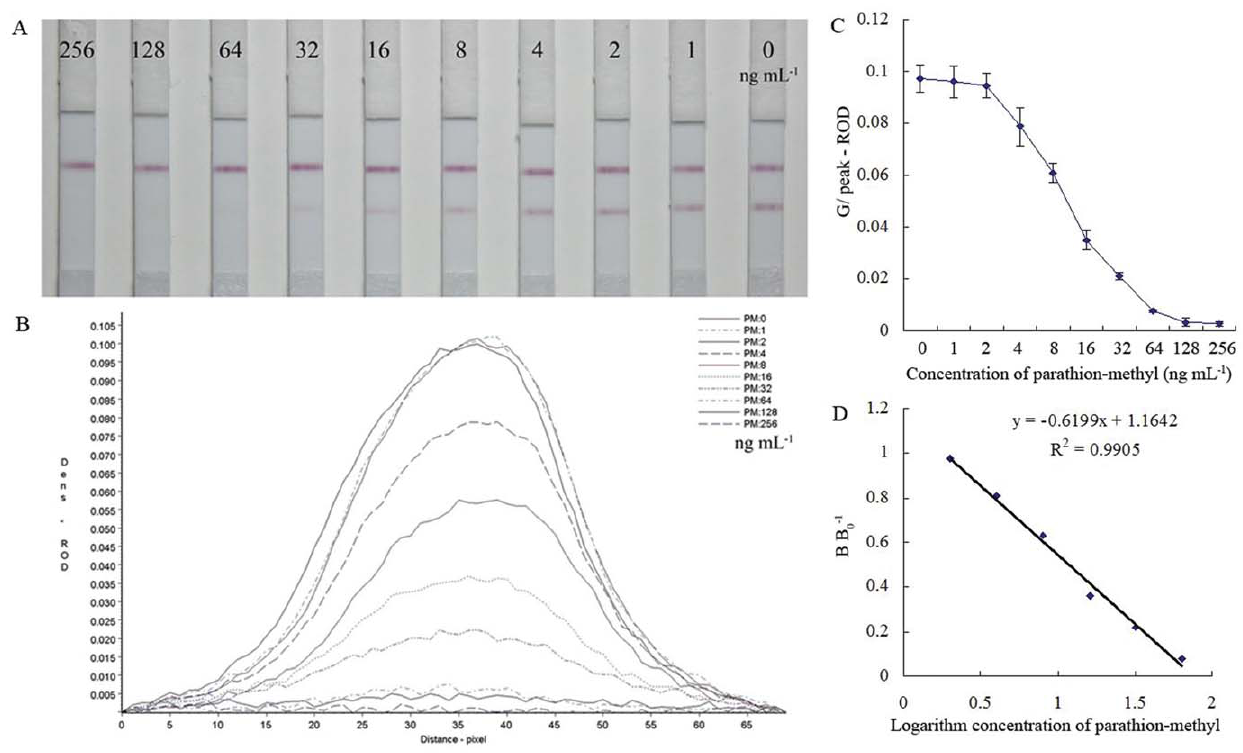
Figure 5. Test sensitivity. A: Concentration range of parathion-methyl standard assayed by the ICA test strip; B: Relative optical density (ROD) curves of parathion-methyl; C: Standard inhibition curves of parathion-methyl; D: The calibration curve from ‘‘A’’; ‘‘B/B0’’ is binding ratio of antibody/ antigen on the test line.